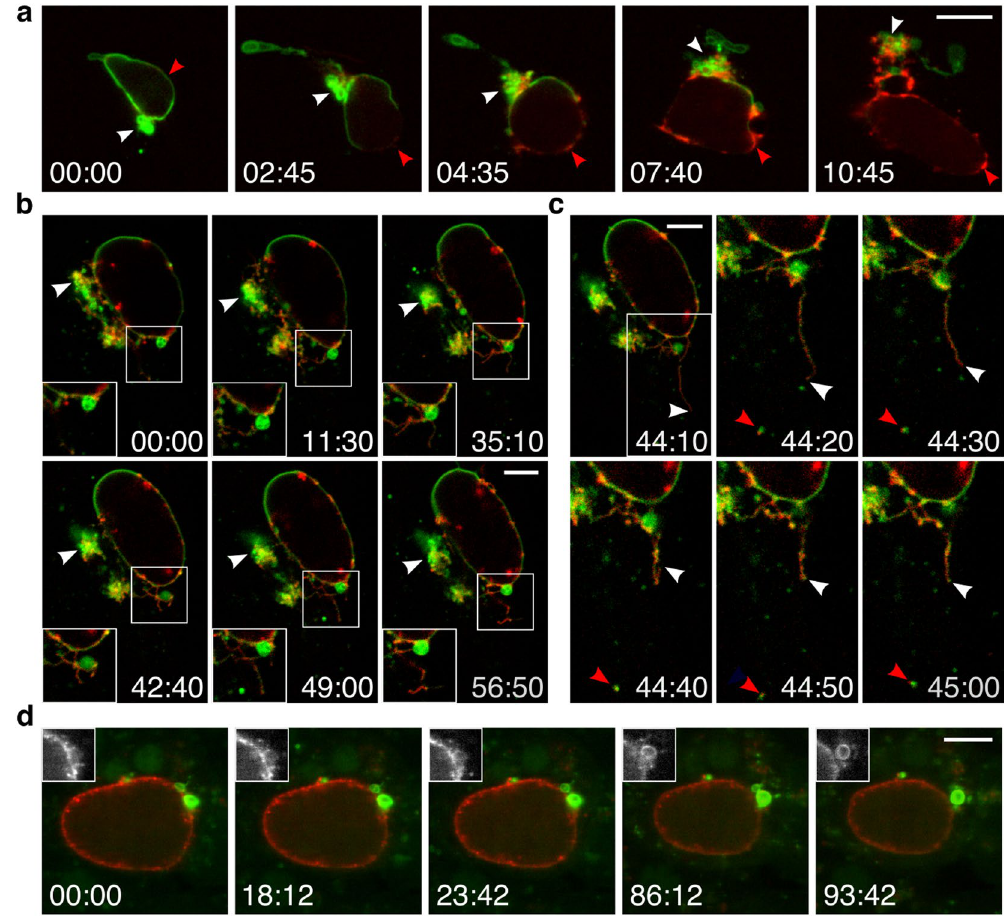
Figure 2. TVN expansion and dynamics promote sequestration of LC3. (a) Long-term imaging of GFP-LC3 HeLa cells infected with schizonts expressing EXP1-mCherry under the late liver stage promoter LISP2 (red, 33 hpi). Translocation of PVM-bound LC3 (red arrowhead) coincides with the TVN expansion (white arrowhead). Acquisition interval 5 min. (b, c) Fast-iterative movie of an infected GFP-LC3 cell displaying the TVN- dynamics. (b) A young EXP1-mCherry schizont (red, 30 hpi) shows rather static cisternae-like clusters, but motile tubules and vesicles. Arrowhead emphasizes LC3 accumulation in the TVN-cluster. (c) Focus on basal TVN region of the EXP1-mCherry schizonts in (b) shows a fast moving tubular structure (white arrowhead) and a PVM-derived LC3-vesicle (red arrowhead). Acquisition interval 10 s. (d) Liver intravital microscopy of gfp-lc3 transgenic mice infected with a mature EXP1-mCherry schizont (red, 41 hpi). Residual LC3 (green) locates to the EXP1-positive TVN, highlighted in the inset. Acquisition interval 5 s. Time stamps, h:min (a) , min:s (b–d) . Scale bars, 10 µ m (a, d) , 5 µ m (b, c)